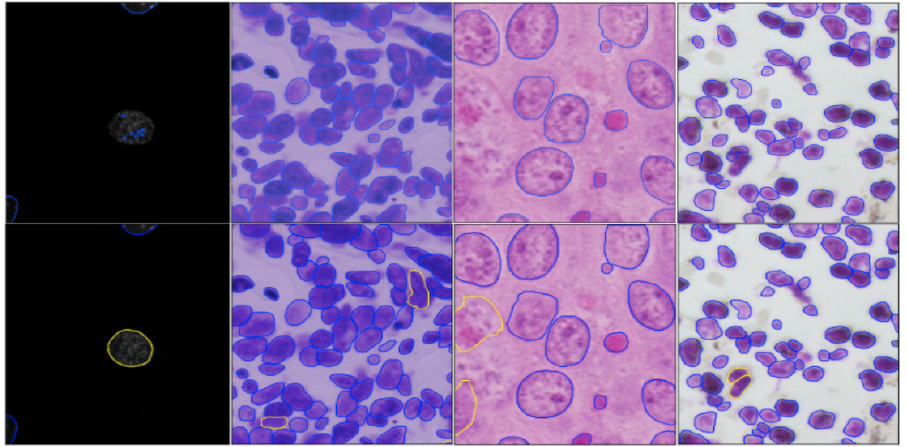
Figure 4. Nuclei segmentation results without ( first row ) and with ( second row ) our augmenta- tion. Agreeing mask contours are shown in blue. Yellow contours in the second row show the improvements compared to the first